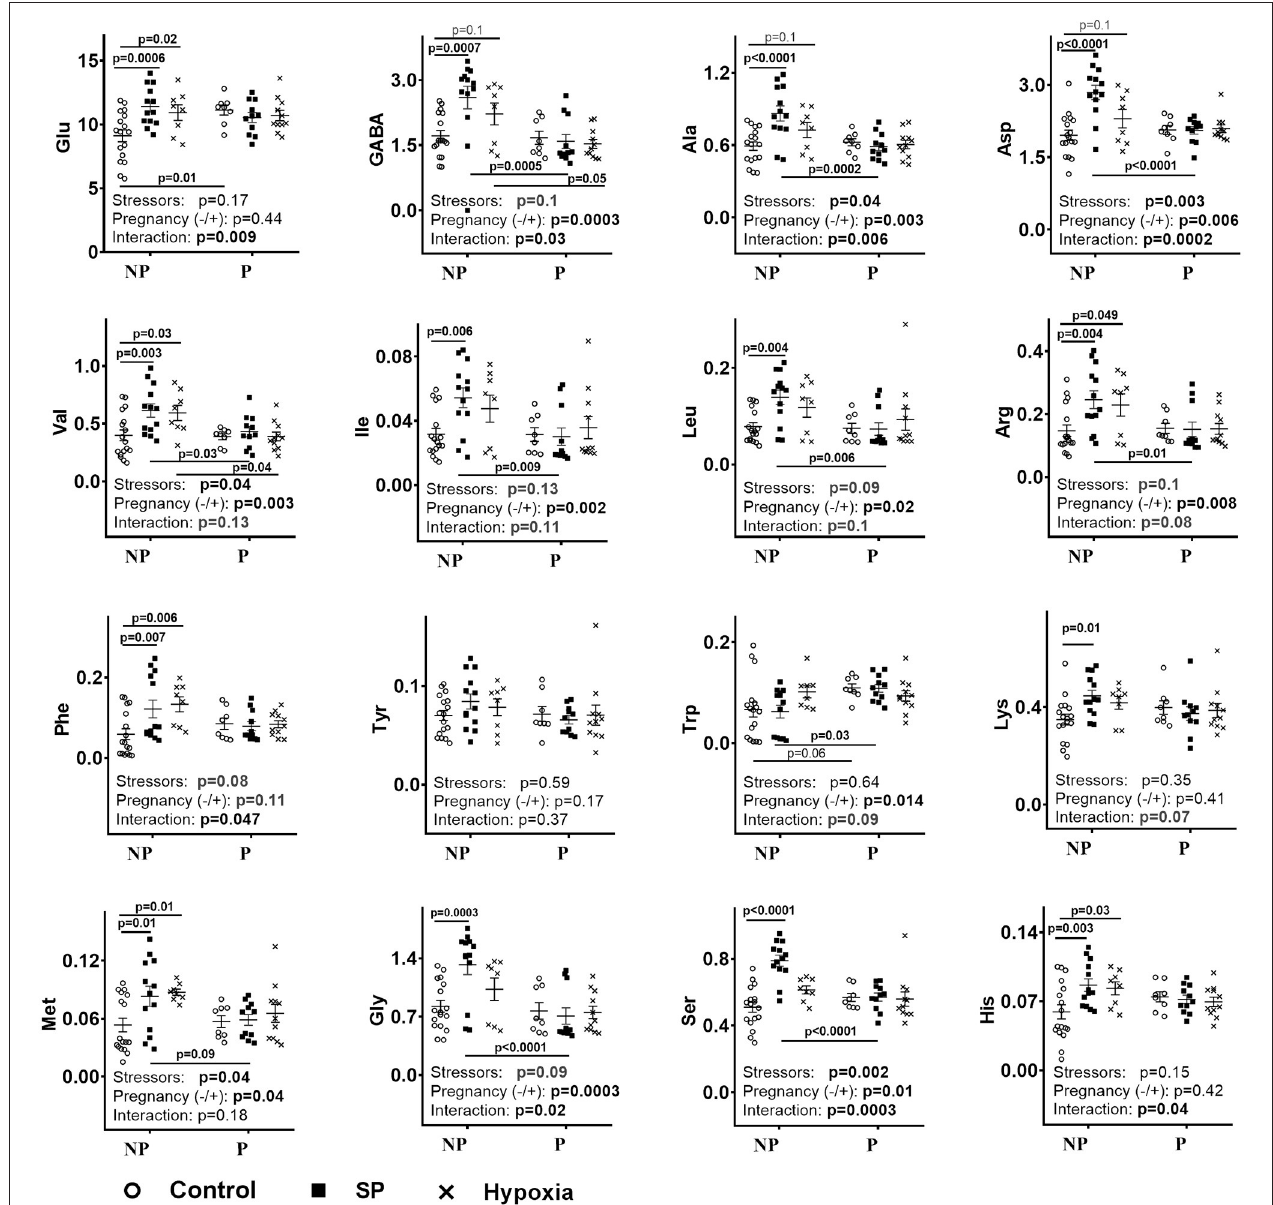
FIGURE 1 | Influence of succinyl phosphonate (SP) on the cerebellar levels of amino acids in the non-pregnant (NP) and pregnant (P) rats and comparison of the SP effects to those of acute hypobaric hypoxia. The content of free amino acids indicated on Y -axes is shown in micromoles per grams of fresh tissue weight. NP—non-pregnant rats: control n = 17, SP n = 13, hypoxia n = 8. P—pregnant rats: control n = 8, SP n = 11, hypoxia n = 10. The comparison of the effects of SP and hypoxia employs the data on hypoxic rats obtained earlier (9). Statistical analysis by two-way ANOVA is described in Methods. Statistically significant differences between the groups determined by the post-hoc test, and significance of the factors (stressors SP or hypoxia and pregnancy) and their interaction determined by ANOVA, are given on the graphs.